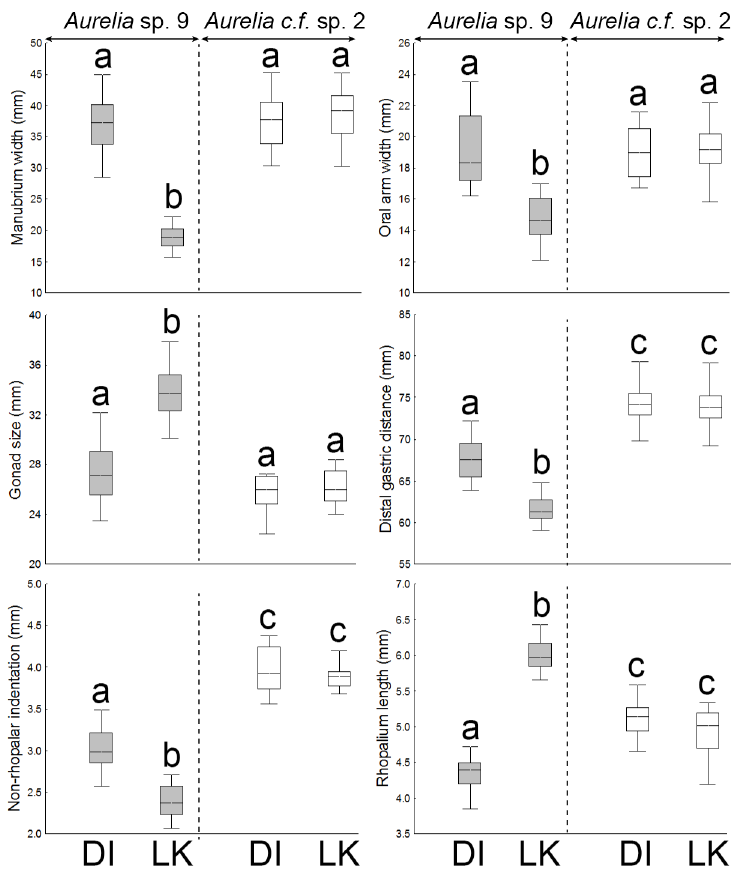
Fig 8. Morphological variation in continuous, size-corrected features of Aurelia medusae in the Gulf of Mexico. DI: Dauphin Island (AL), which represents the Central Northern Gulf of Mexico. LK: Long Key (FL), which represents the Southeastern Gulf of Mexico. Features explaining 90% of the total morphological variation (SIMPER) are shown. Different letters above whiskers indicate significant differences among groups detected by post-hoc Tukey ’ s tests (P < 0.0001). Boxes: median, the 25 – 75% quartiles. Whiskers: Non- outlier range. Circles: